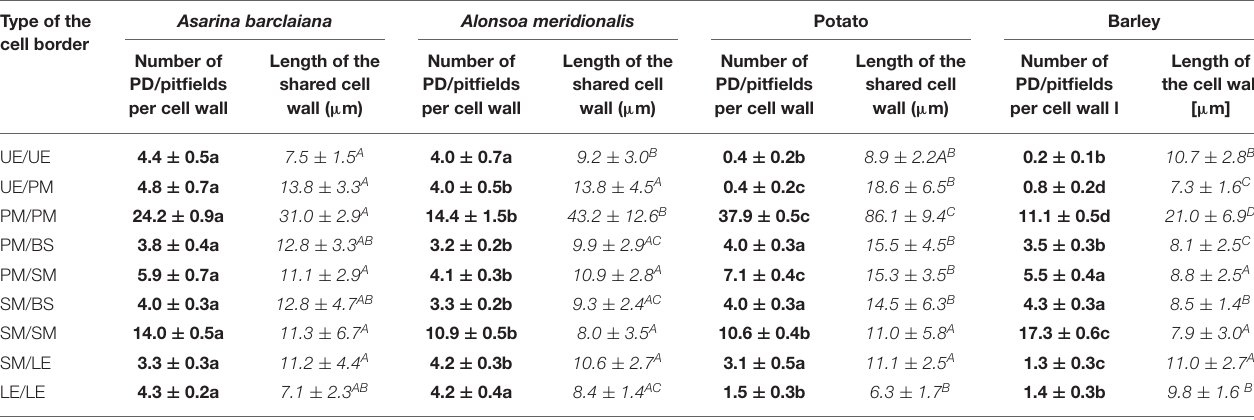
TABLE 1 | Numbers of fluorescent puncta per cell wall corresponding to anti-calreticulin-labeled PD/pitfields, and the mean lengths of shared cell walls between abutting specified cell types expressed on a per cell basis (in µ m), as determined for nine types of cell/cell boundaries in leaves of A. barclaiana , A. meridionalis , barley, and potato. Type of the cell